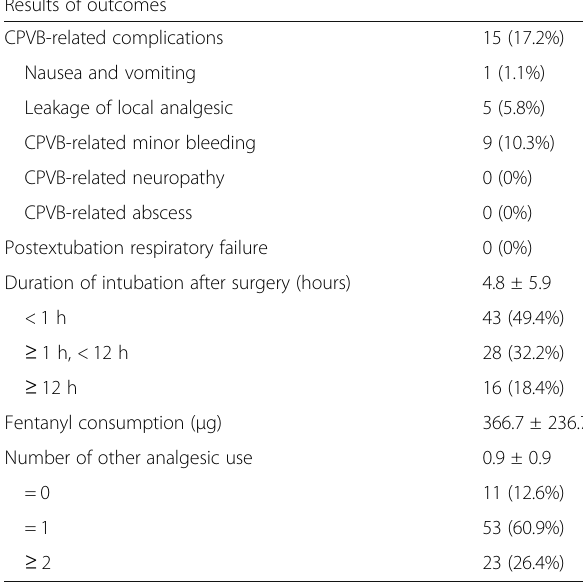
Table 2 Outcomes ( n = 87) Results of